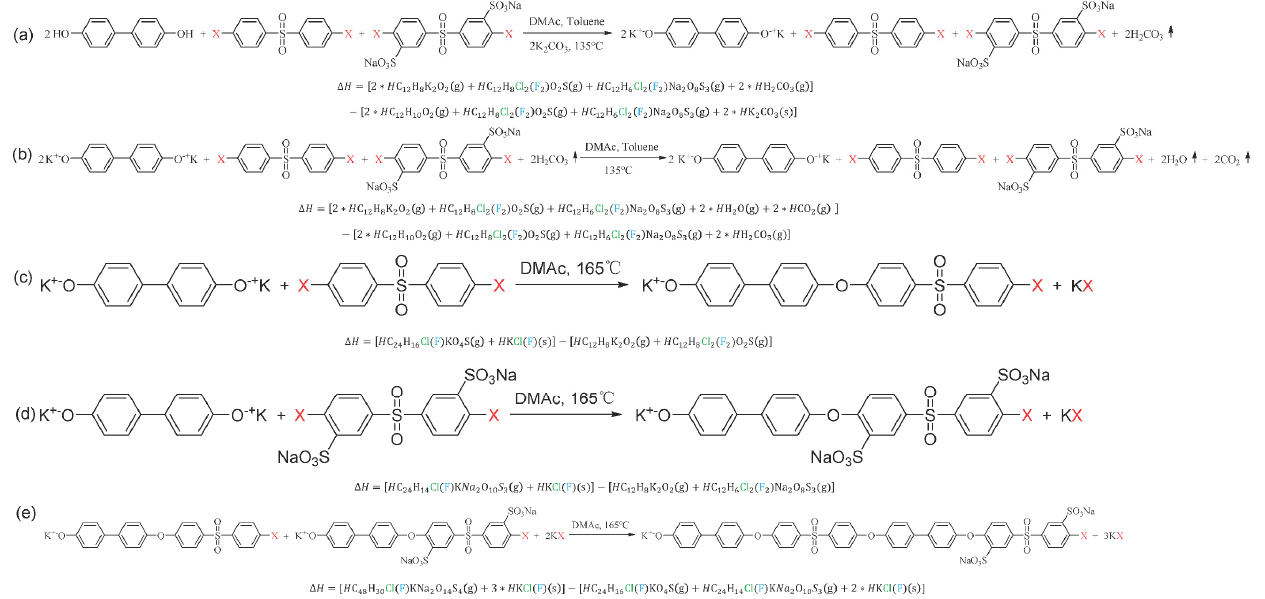
Figure 7. Each synthesis step and the equation of enthalpy change ( Δ H ): ( a ) BP( ‐ OH form) is converted to BP( ‐ OK form); ( b ) carbonic acid is converted to water and carbon dioxide; ( c ) BP( ‐ OK) and DC(F)DPS are bonded to form a hydrophobic domain; ( d ) BP( ‐ OK) and SDC(F)DPS are bonded to form a hydrophilic domain; ( e ) hydrophobic and hydrophilic domains are bonded to form a single SPAES unit.